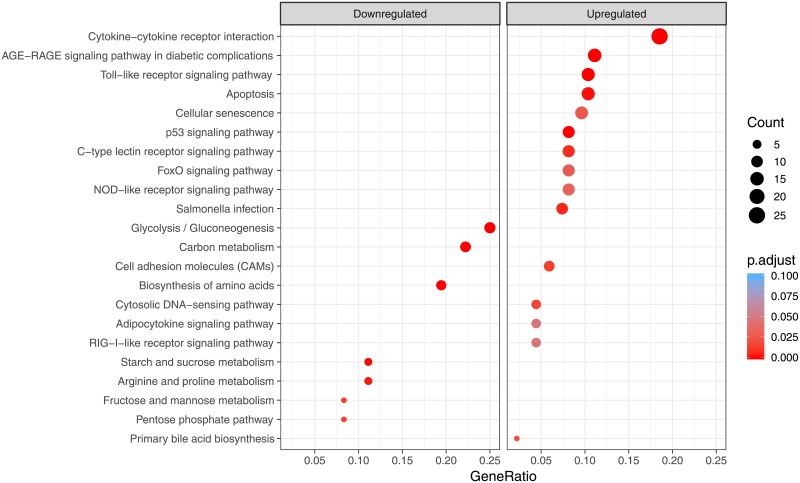
KEGG analysis of the differentially expressed genes from vaccinated fish comparing to control fish.Color gradient from red to blue, where red indicates high enrichment (low p.adjust) and blue indicates low enrichment (high p.adjust). Dot size corresponds to count (number of DEGs in each pathway).